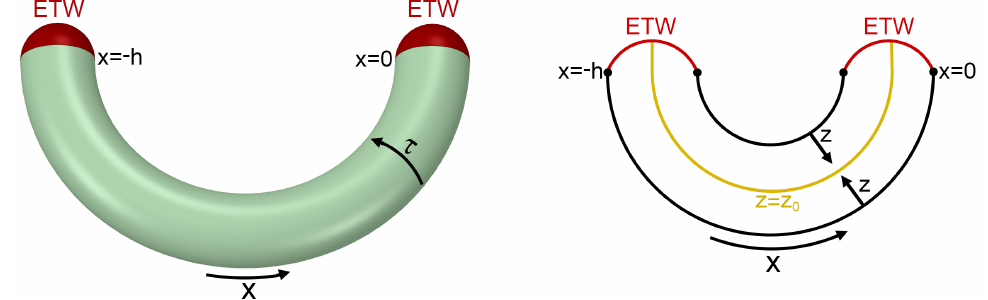
Figure 6 . Left: bulk dual of the finite cylinder in the BTZ phase. The non-contractible x circle is cut off at x = − h, 0 at the boundary. Two disconnected ETW branes extend from such boundary circles into the bulk. In the positive tension brane case depicted here, the spacetime is enlarged with respect to the tensionless case. The bulk domain is given by τ ∈ [ − π, π ] , z ∈ [0 , 2 Right: constant τ slice of the bulk spacetime in the BTZ phase. Such a slice is defined by τ = c, c ± π for some constant c